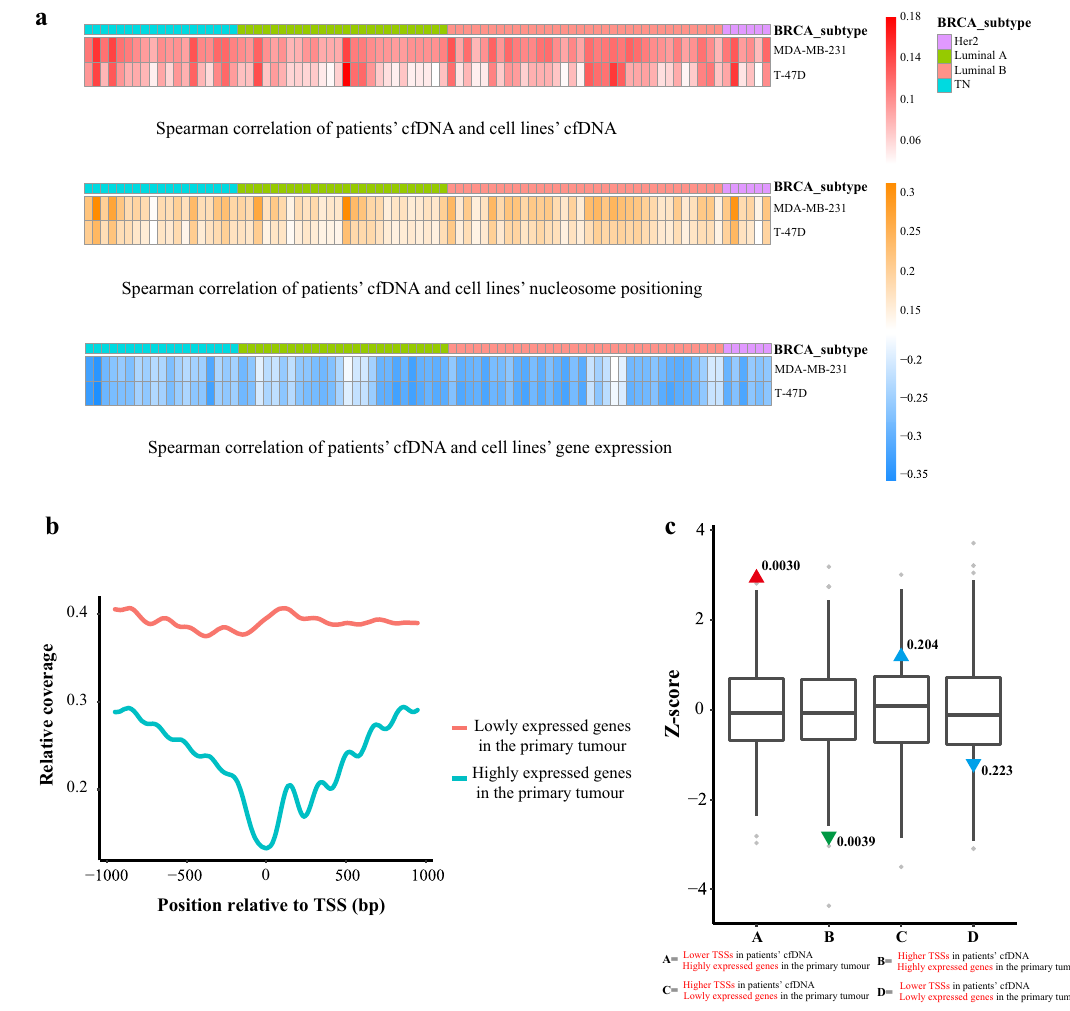
Fig. 4 Breast cancer patients ’ cfDNA coverage is related to gene expression in breast cancer cells. a Correlations between DTSSs by circulating cell-free DNA-seq from 85 breast cancer patients and DEGs matched by mRNA-seq, DTSSs by MNase-seq, and DTSSs by cell-free DNA-seq in the MDA-MB-231 cell line and T-47D cell line. b Circulating cell-free DNA-seq read depth maps of promoter regions from 85 breast cancer patients for highly expressed genes (TPM > 10, blue) and unexpressed genes (TPM = 0, red) in the MDA-MB-231 cell line and T-47D cell line. c Overlaps of coverage depth around TSSs of expressed genes in primary tumor tissue compared to adjacent breast tissue (TCGA) in breast cancer patients ( n = 85) compared to healthy donors ( n = 85). Box plots represent the expected null distribution of overlaps from 1000 permutations (two sided, p values com p uted using a standard normal distribution). The extremes of the boxes de fi ne the upper and lower quartiles, and the center lines de fi ne the median. Whiskers indicate 1.5 times the interquartile range (IQR). Triangles represent observed overlap (red if signi fi cantly enriched, green if signi fi cantly